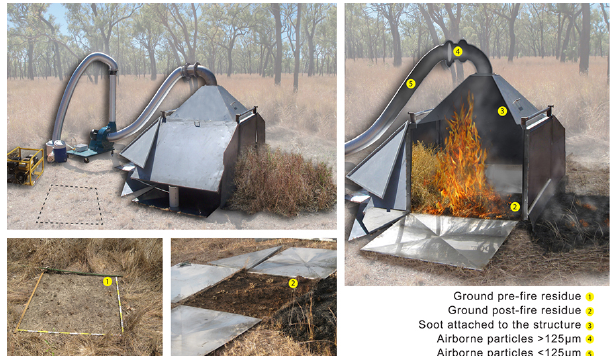
Figure 3. Schematic diagram depicting an experimental burn, with pre- and post-fire C pools. Initial biomass and PyC inventory were quantified in the near vicinity of each planned burn location by means of destructively collecting all aboveground plant material and vacuuming the soil surface from two 1m 2 census quadrats, as shown in left bottom